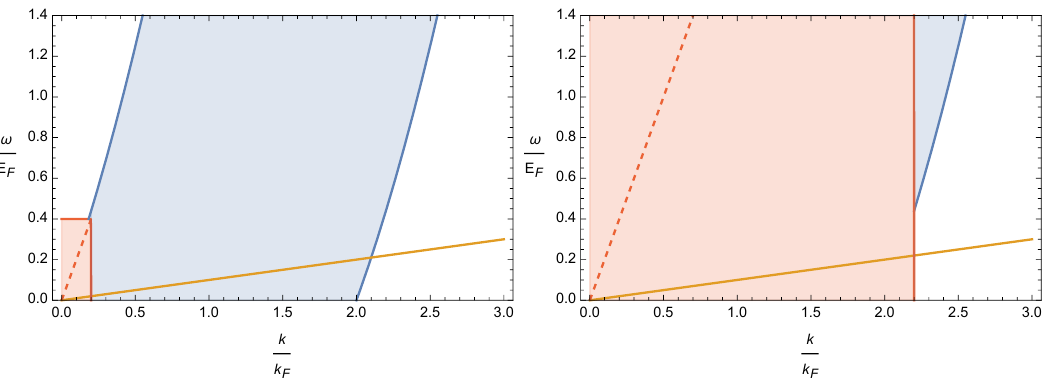
Figure 4: Collective (shaded red) and Lindhard (shaded blue) regimes in a con- ventional metal (left) and a bad metal (right). The collective regime extends over (cid:28) k k (cid:174) 2 π/(cid:96) . The good metal has 2 π/(cid:96) while the bad metal has 2 π/(cid:96) F e e The dispersion of the acoustic phonon is the orange line. The dashed red line shows ω = v = v τ k , with (cid:96) F F e e